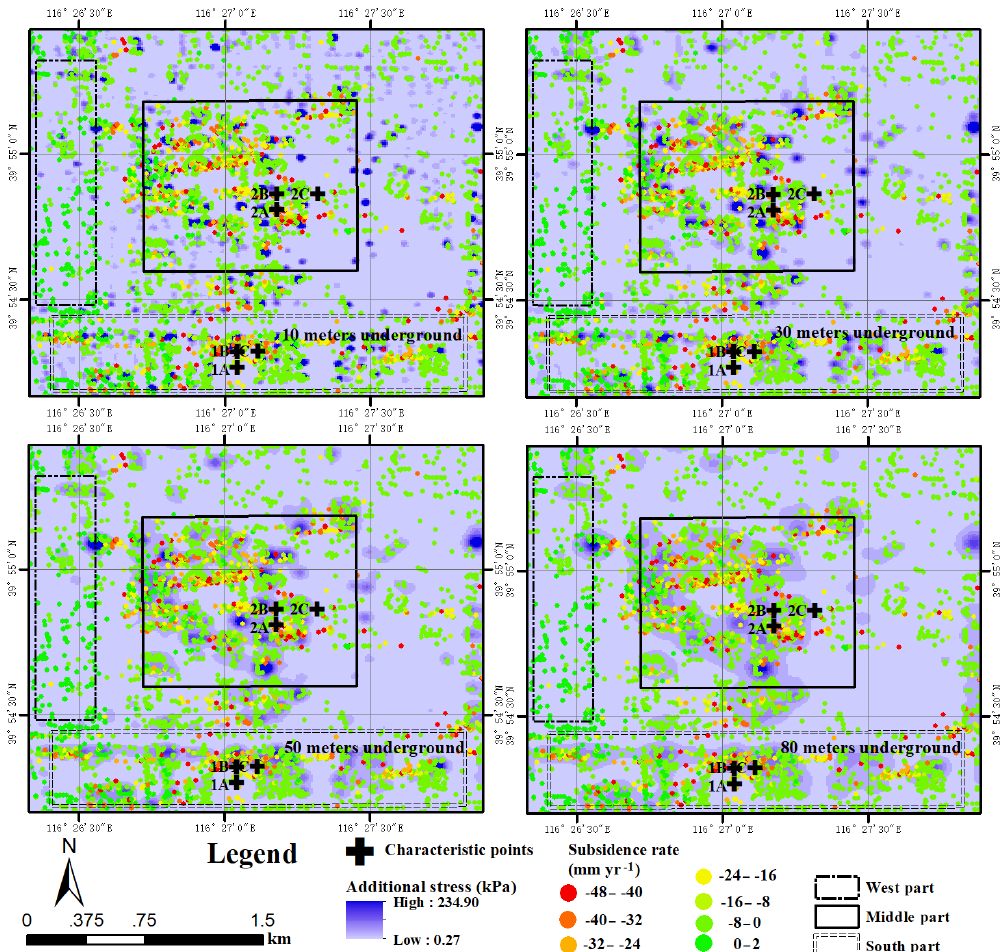
Figure 2. Land subsidence rate map and additional stress derived from building loads at different depths in the Central Business